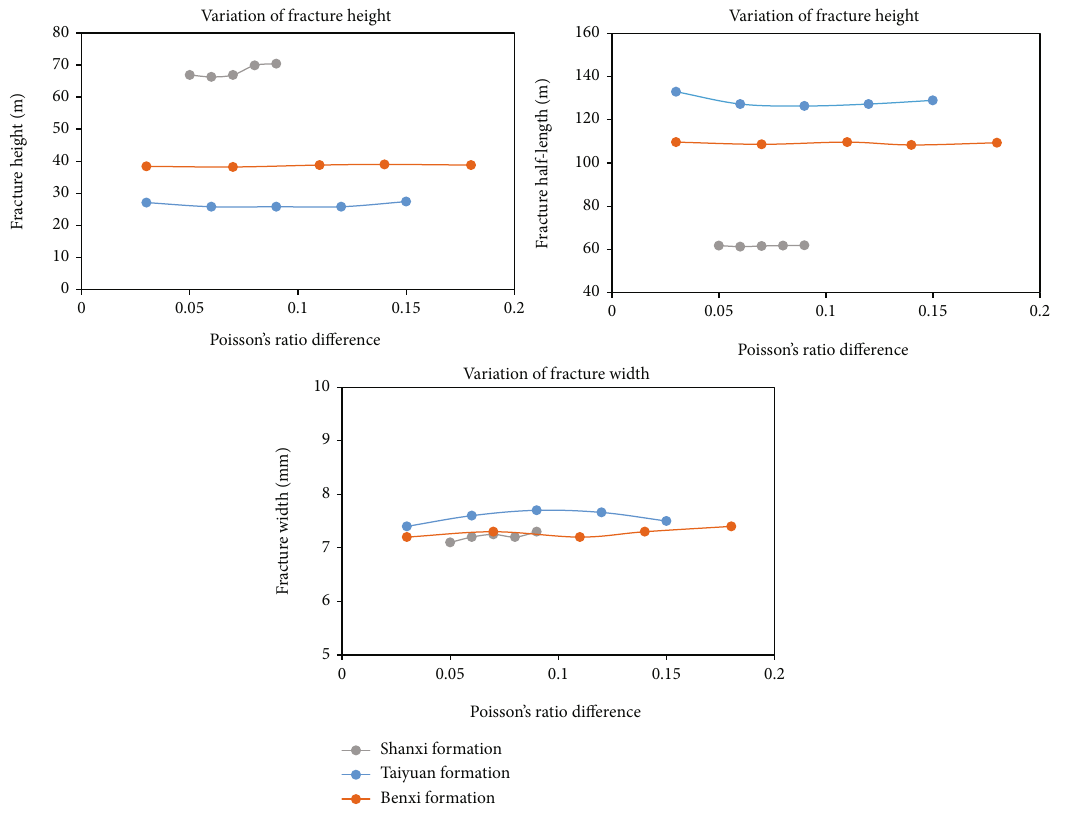
Figure 8: Variation of hydraulic fracture shape with the Poisson ’ s ratio di ff erence.